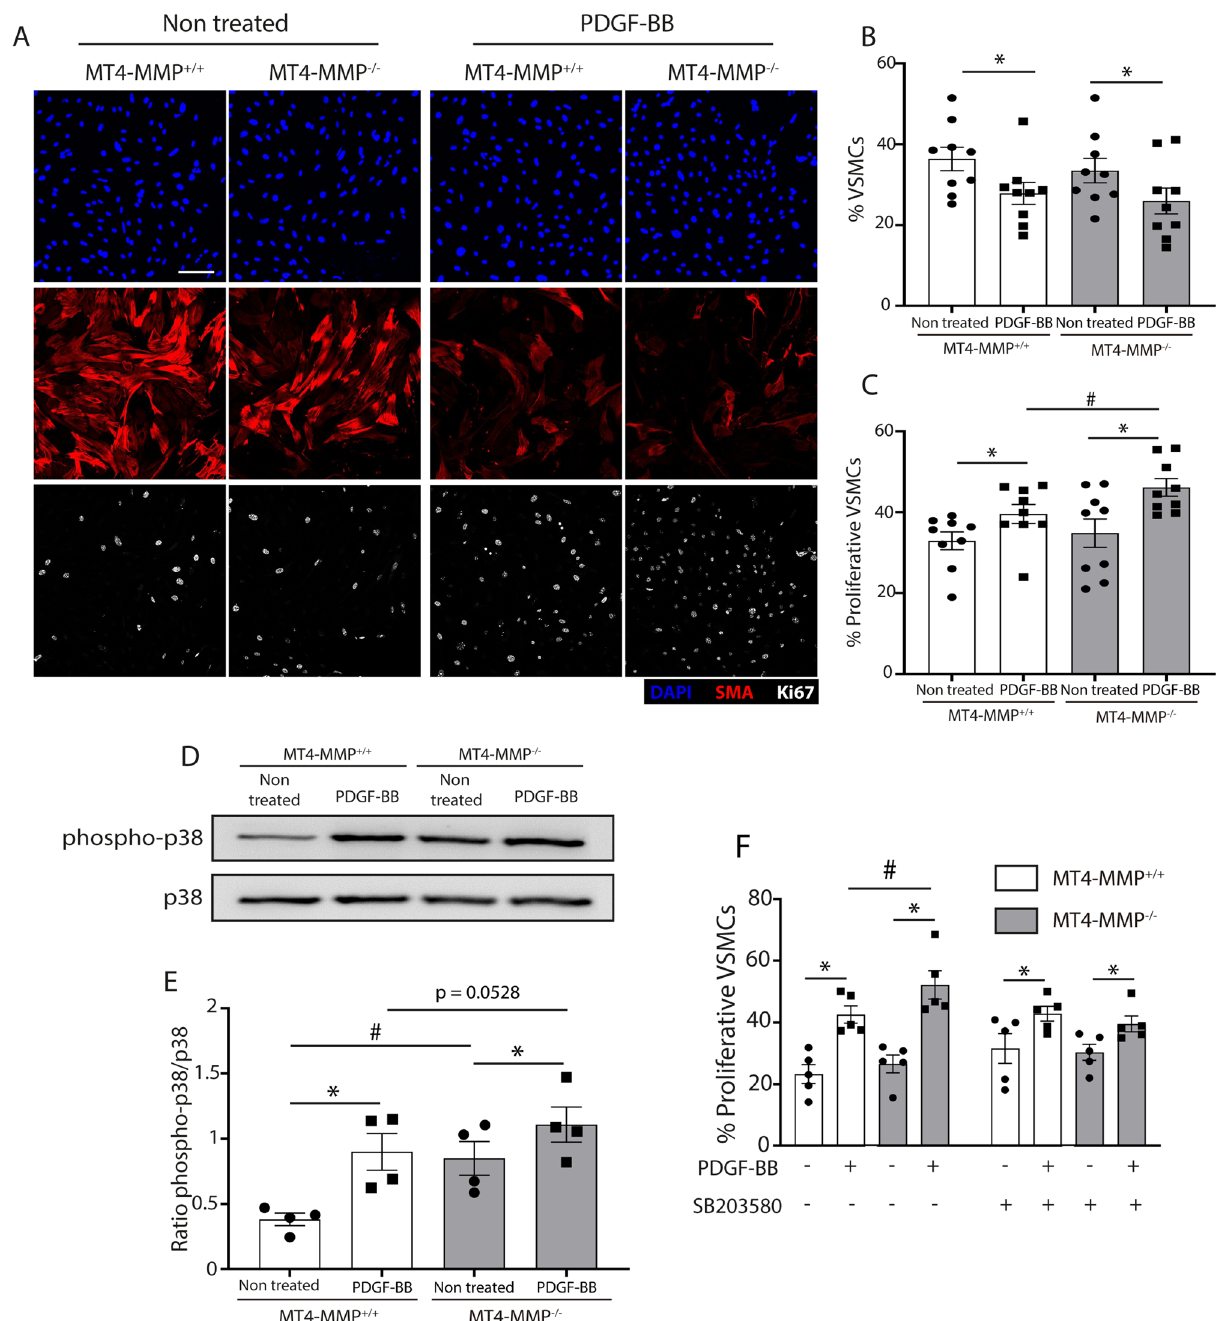
Figure 1. p38 MAPK signaling is increased in MT4-MMP-null VSMCs in vitro leading to boosted VSMC proliferation upon PDGF-BB treatment. ( A ) Representative confocal microscopy images showing immunostaining for SMA, Ki67 and DAPI in MT4-MMP +/+ and MT4-MMP −/− aortic VSMCs treated or not with PDGF-BB. Scale bar: 50 µm. ( B , C ) Quantification of the percentage of VSMCs (% SMA + in DAPI + cells) and proliferative VSMCs (% Ki67 + in SMA + cells). n = 9 VSMC cultures in 9 independent experiments. ( D ) Representative Western blot of phospho-p38 and p38 in lysates of MT4-MMP +/+ and MT4-MMP −/− aortic VSMCs treated or not with PDGF-BB. ( E ) Quantification of phospho-p38 normalized to total p38. n = 4 VSMC cultures in 4 independent experiments. ( F ) Quantification of the percentage of proliferative VSMCs (% Ki67 + in SMA + cells) in MT4-MMP +/+ and MT4-MMP −/− aortic isolated VSMCs treated or not with PDGF-BB in presence or absence of p38 inhibitor (SB203580). n = 5 VSMC cultures in five independent experiments. In ( B , C , E , F ) data are means ± s.e.m. analysed by two-way ANOVA followed by Benjamini and Hochberg post-test; *, # p <